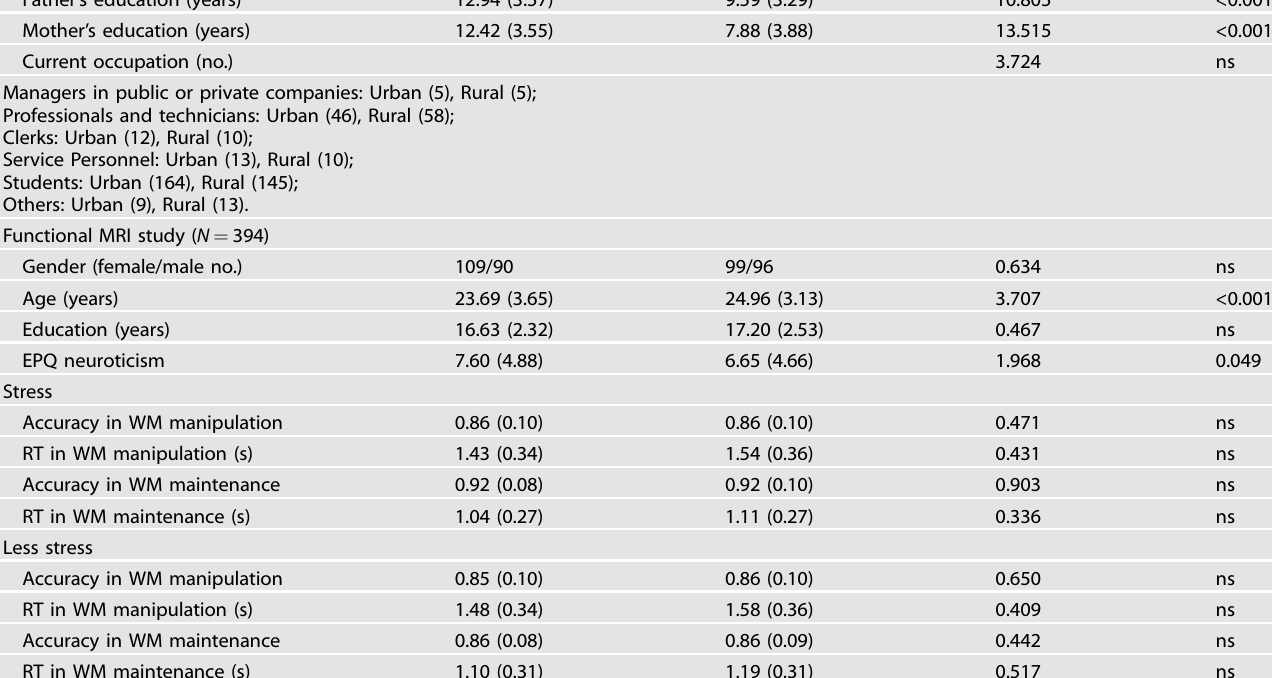
Current occupation